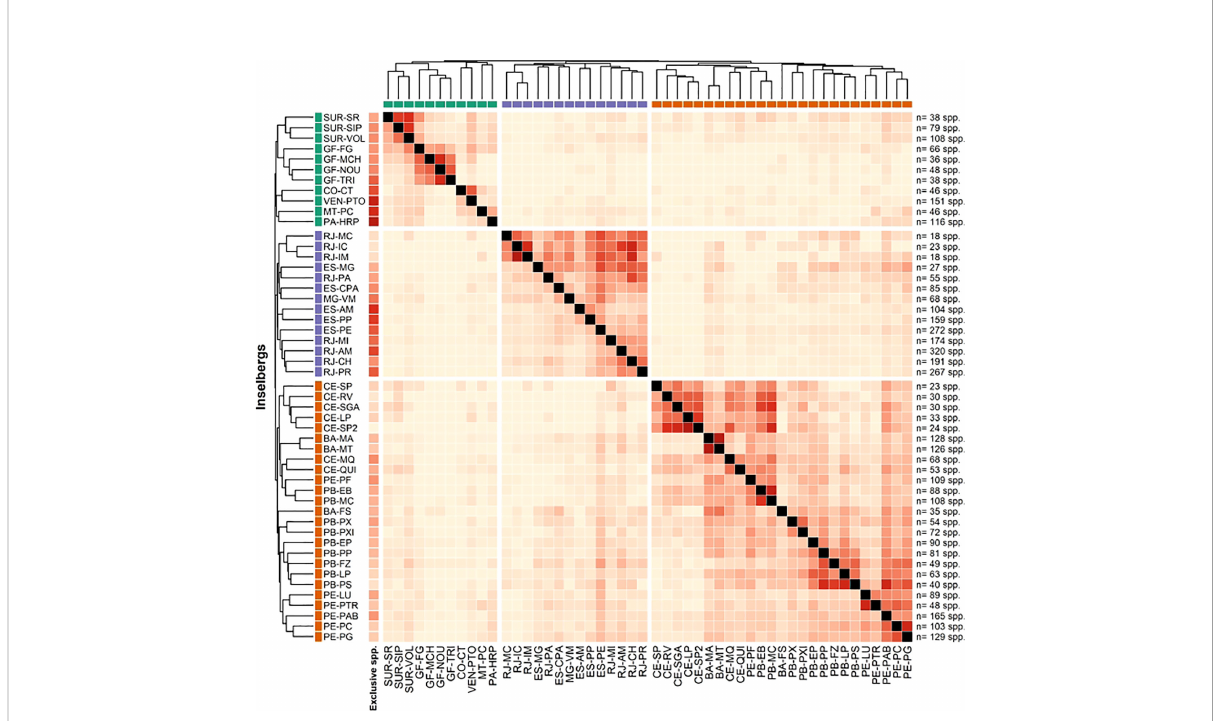
FIGURE 4 Heatmap of similarity between the inselberg fl oristics datasets. Dendrograms were plotted using the unweighted-pair-group method with arithmetic mean (UPGMA). The colors indicate the proportion of shared species, ranging from yellow (low values, less similarity) to red (high values, higher